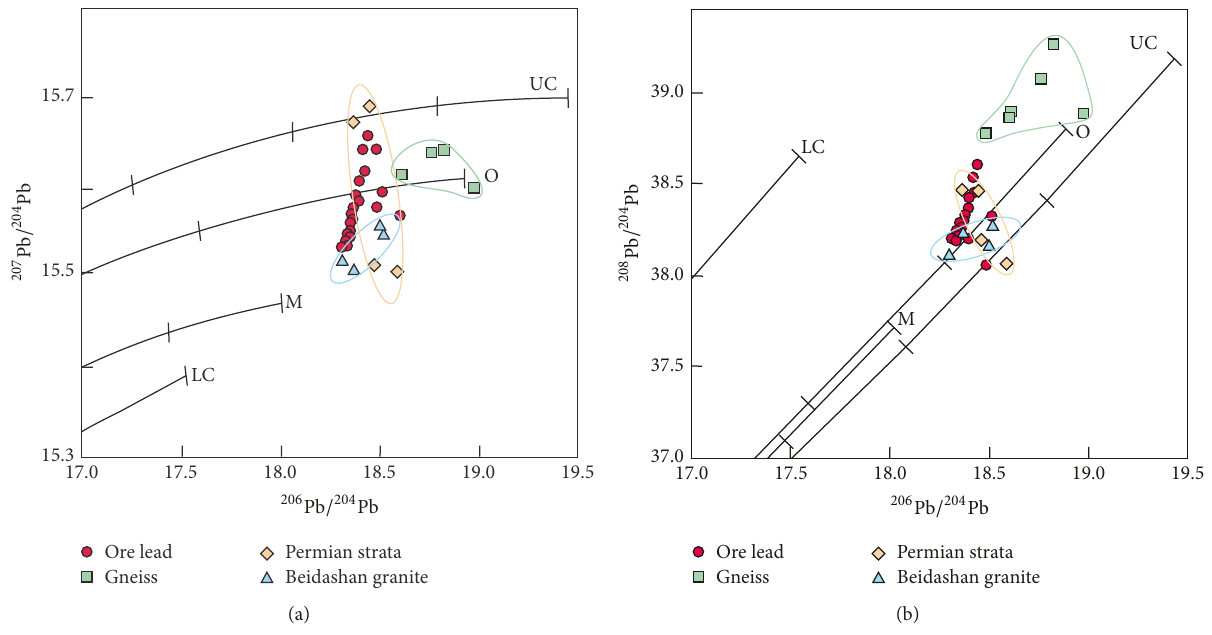
Figure 9: Lead isotope compositions for sulfides and host rocks in the Bairendaba Ag-Zn-Pb deposit. (a) 207 Pb/ 204 Pb versus 206 Pb/ 204 Pb plot; (b) 208 Pb/ 204 Pb versus 206 Pb/ 204 Pb plot. UC (upper crust), O (orogen), M (mantle), and LC (lower crust). The average growth curve is from Zartman and Doe [48]. Lead isotope data for ore are from Ouyang [33] and from Jiang et al. [17], Chu et al. [49], and Zeng et al. [50] for Permian strata; Jiang et al. [17] for gneiss; and Jiang et al. [17] and Wang [51] for the Beidashan granite.